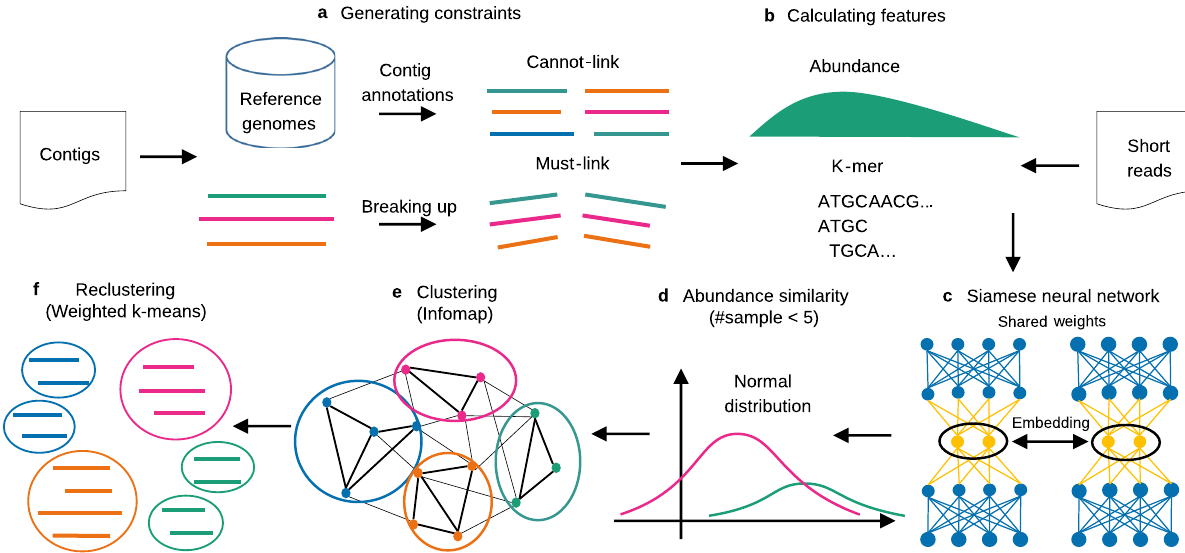
Fig. 1 Overview of the SemiBin pipeline. a generate must-link constraints by breaking up contigs arti fi cially and cannot-link constraints based on contig taxonomic annotations (i.e. GTDB reference genomes). b calculate abundance estimates (average and variance of the number of reads per base) and k -mer frequency of every contig. c train siamese neural network using the cannot-link and must-link constraints as inputs ( k -mer frequencies and abundance features). The learned embedding will be the features from the output layer of the neural network and be used in step e for binning. d Based on the assumption that the number of reads per base obeys a normal distribution, calculate the Kullback-Leibler divergence of the normal distributions of two contigs. SemiBin uses this value as the abundance similarity when the number of samples used is smaller than 5. e generate a sparse graph with the embedded distance and abundance similarity between contigs and uses the Infomap algorithm to obtain the preliminary bins. f SemiBin uses weighted k - means to recluster contigs in the bins whose mean number of single-copy genes is greater than one to get the fi nal